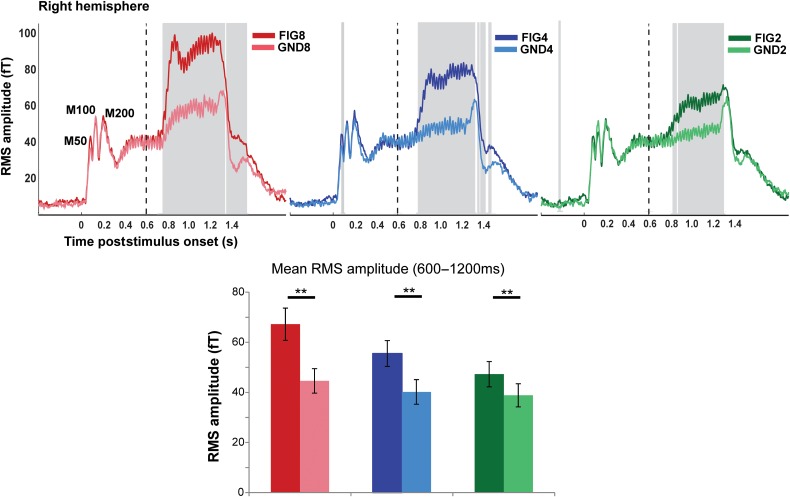
MEG evoked responses to the basic SFG stimulus. (Top) Each plot depicts the group-RMS response to the basic SFG stimulus in the right hemisphere (left hemisphere responses are identical). The onset of the stimulus occurs at t = 0 and offset at t = 1200 ms, the transition to the figure, as indicated by the dashed vertical lines, occurs at t = 600 ms. The responses to the figure and ground segments are shown in the darker and lighter shade of each color: red (FIG8 and GND8), blue (FIG4 and GND4), green (FIG2 and GND2). The shaded gray bars indicate times where a significant difference between the response to the figure and its corresponding control stimulus was observed (based on bootstrap analysis; see Materials and Methods). (Bottom) Mean RMS amplitude in each of the conditions computed over the figure interval (between 600 and 1200 ms poststimulus onset). A repeated-measures ANOVA analysis indicated significant differences between each FIG and GND pair. ** indicates P ≤ 0.01.